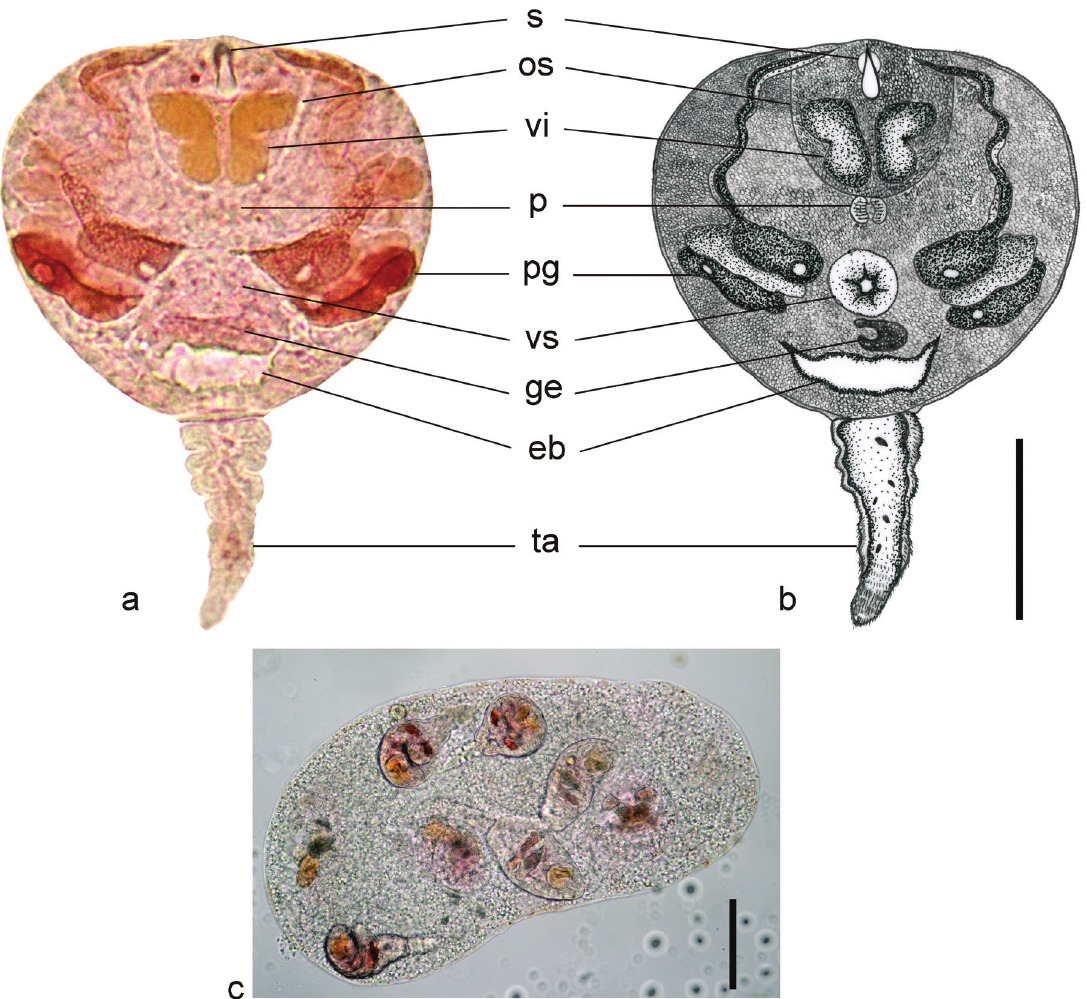
Figure 3. Images of Loxogenoides bicolor (Krull, 1933). a . specimen stained with 0.5% neutral red. b . drawing of cercaria. c . spo- rocyst stained with 0.5% neutral red. Abbreviations – eb: excretory bladder; ge: genital primordium; p: pharynx; pg: